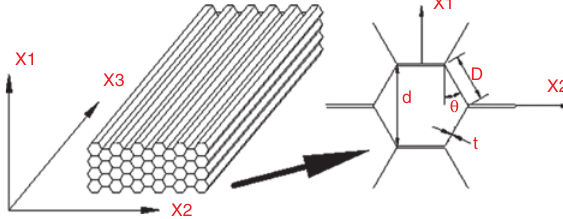
Figure 3 In-plane uniaxial compression